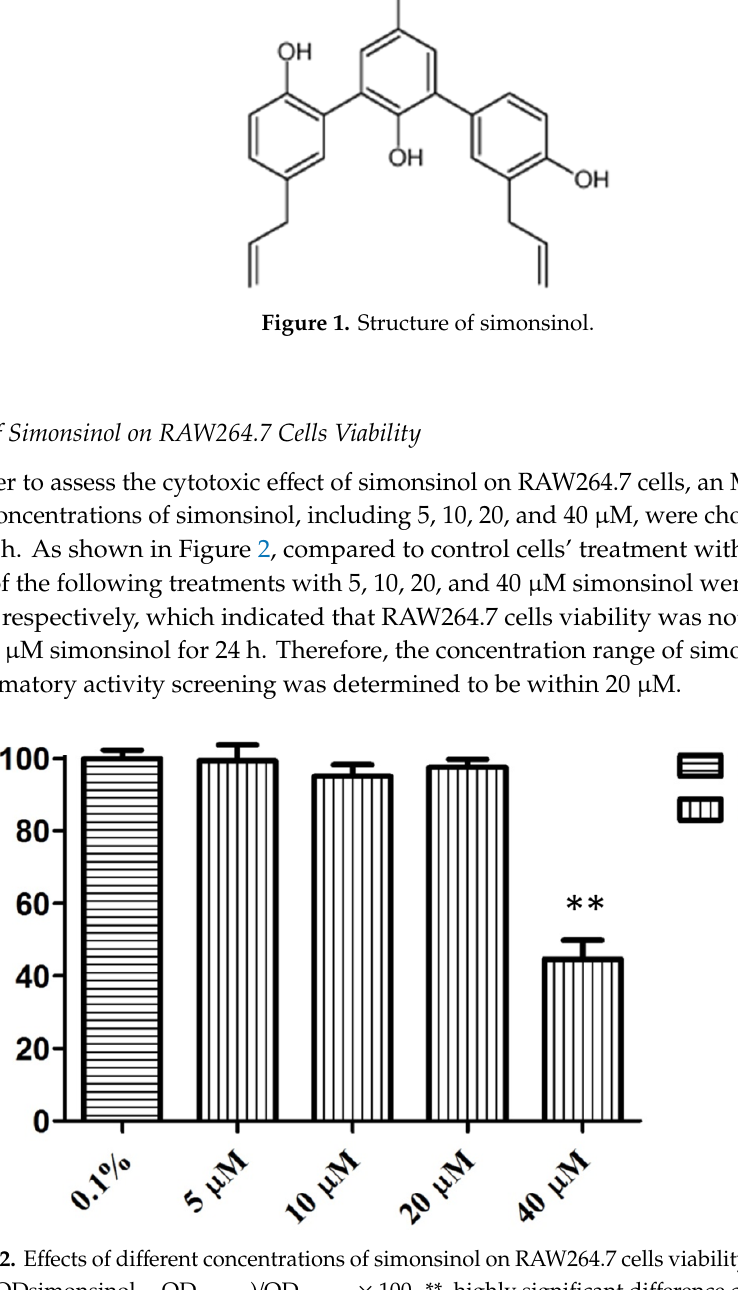
Figure 2. Effects of different concentrations of simonsinol on RAW264.7 cells viability. The cells viability (%) = (ODsimonsinol − OD DMSO )/OD DMSO × 100. **, highly significant difference compared to control cells that treated by DMSO. ( p < 0.01).